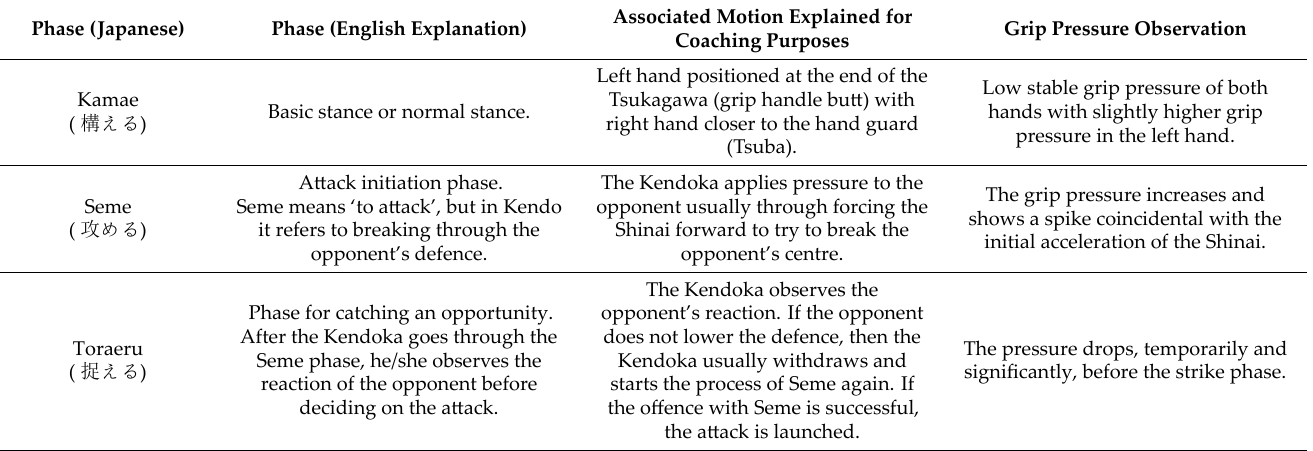
Table 4. Summary of the five attack phases in terms of motions and associated grip